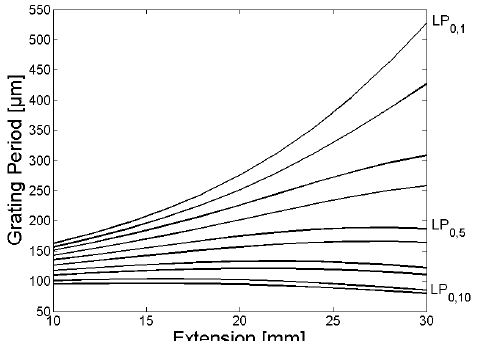
Figure 6. The calculated grating periods to couple light from the fundamental LP 0,1 core mode to the LP 0,1 –LP 0,10 cladding modes for the SM1500 fiber with a starting cladding diameter of 80 μ m are shown as function of the fiber extension, whereby the grating periods for coupling decrease steadily with increasing mode numbers.